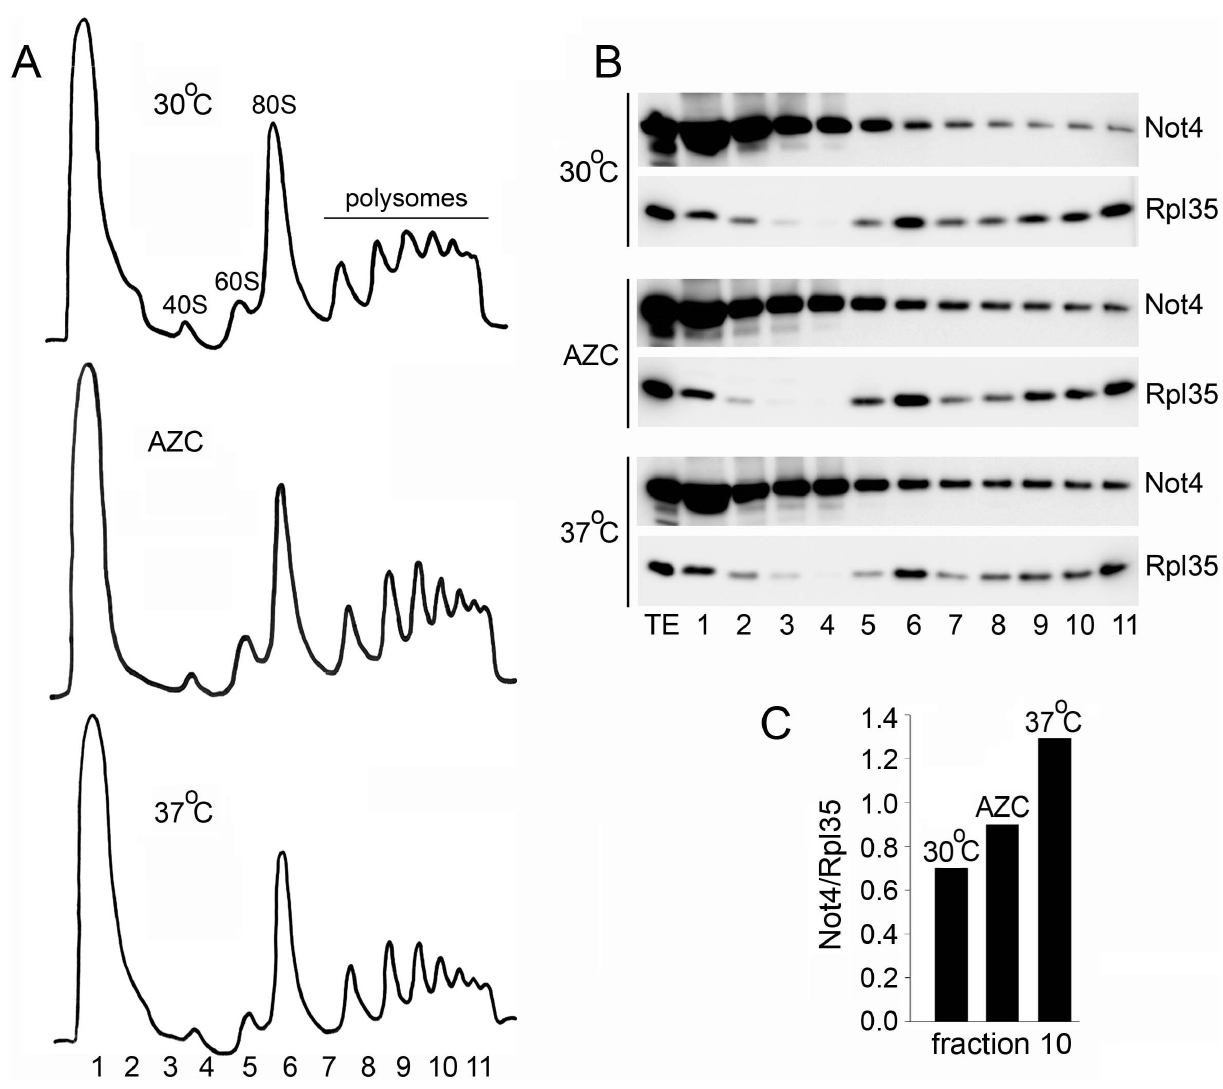
Figure 6. Not4 accumulates in polysomes in response to AZC and high temperature. A. Polysome profiles from the cells expressing Not4- ProteinA. Cells were exponentially grown on YPD media at 30 u C or 37 u C, as indicated, and collected at OD 600 of 1.0. When indicated, cells were treated with 0.4 mg/ml of AZC. AZC was added at OD 600 of 0.15 and cells were grown till OD 600 of 1.0 and collected. Extracts, containing 3 mg of total proteins, were subjected to 7–47% sucrose gradient centrifugation and analyzed by UV reading at 254 nm. Fraction numbers and the positions of 40S, 60S, 80S, and polysomes are indicated. B. Fractions were collected and analyzed by western blot with PAP and Rpl35 antibodies. C. Not4 content in polysomes was quantified. For this the Not4 signal in polysomes (fraction 10) was quantified with ImageQuant TL software (GE Healthcare) and normalized on the Rpl35 signal.